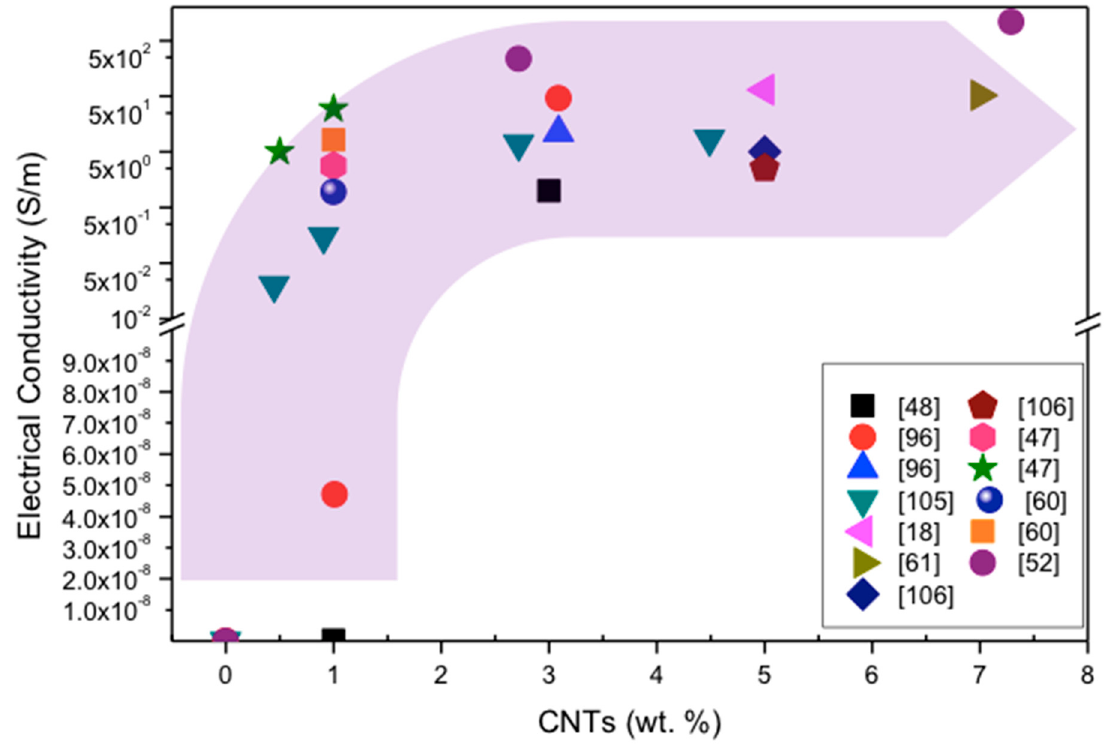
Figure 15. Electrical conductivity of CNT-reinforced silicon nitride composites. The processing routes for the preparation of investigated materials are illustrated in Table 5. The purple highlighted arrow indicates the increasing tendency of electrical conductivity of Si 3 N 4 composites with increasing CNTs content in the matrix.